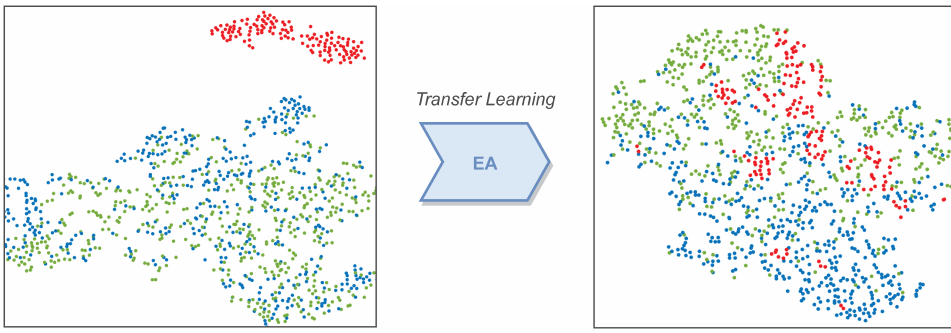
Figure 5. t-SNE visualization before ( left ) and after ( right ) EA.